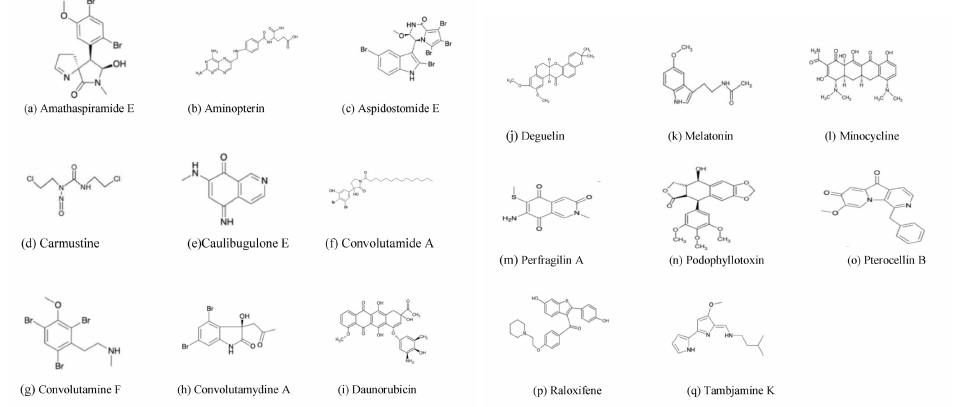
Figure 1. Molecular Structures of Certain Anticancer